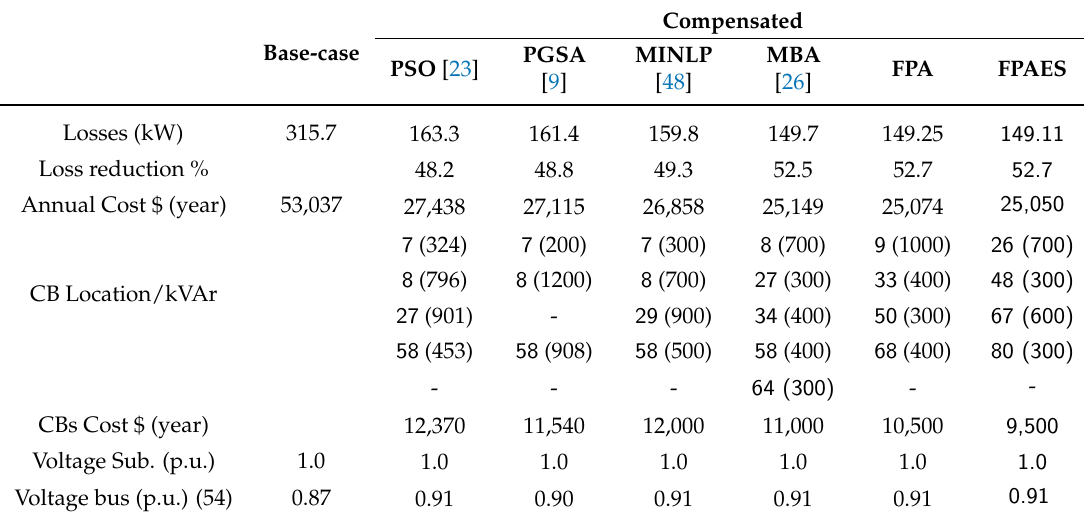
Table 6. Simulation results for the 85-bus system.